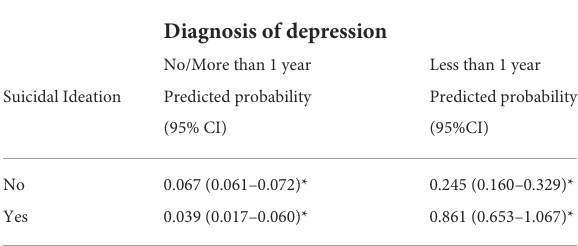
TABLE 3 Predictive probability of suicidal ideation by pregnancy status and diagnosis of depression.